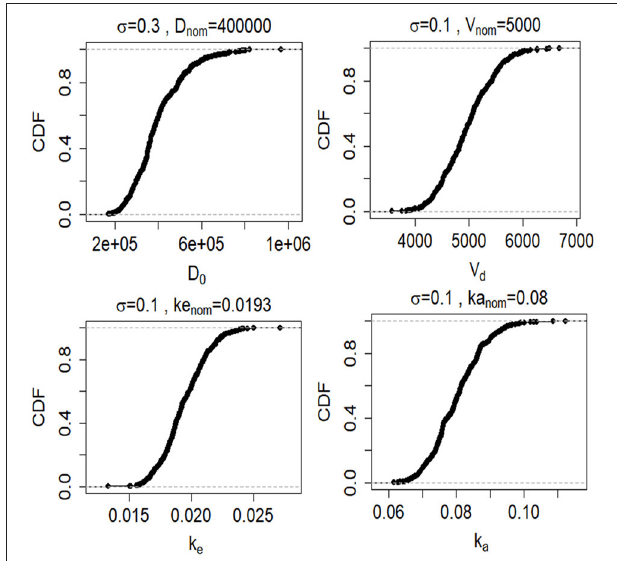
FIGURE 4 | Cumulative distribution functions (CDFs) of 1,000 samples randomly drawn from lognormal probability distributions (described by Equation 7) for the four model inputs and parameters ( D 0 , V d , k e , and k e ). CFs are shown for the GFAP kinetic